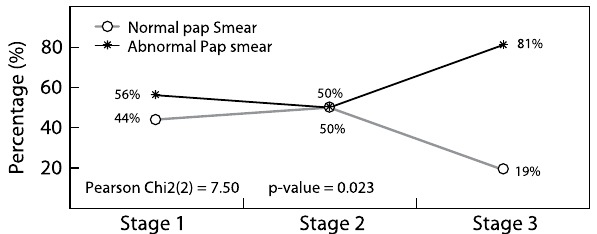
Figure 1: Association between WHO staging with abnormal Pap smears.